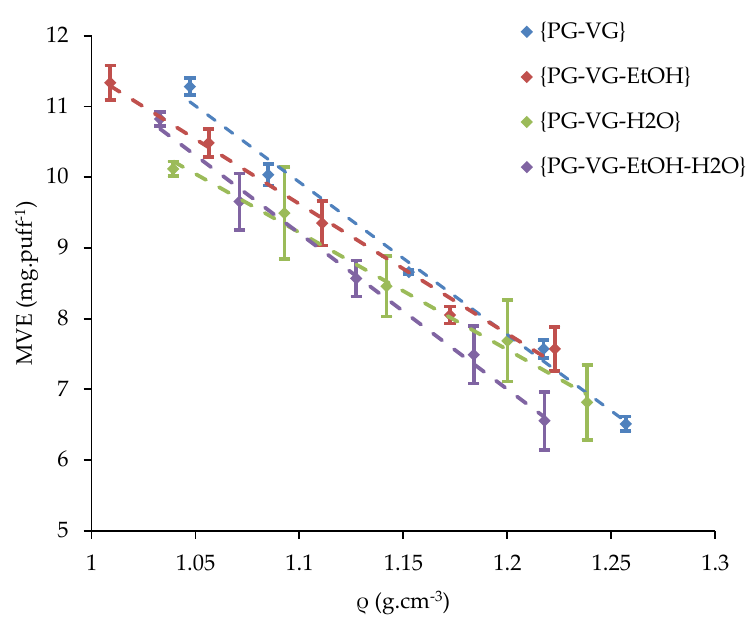
Figure 6. Influence of the densities of {PG-VG}, {PG-VG-EtOH}, {PG-VG-H 2 O}, and {PG-VG-EtOH-H 2 O} mixtures on their MVE (measured at ambient temperature, with a supplied power of 15 W).